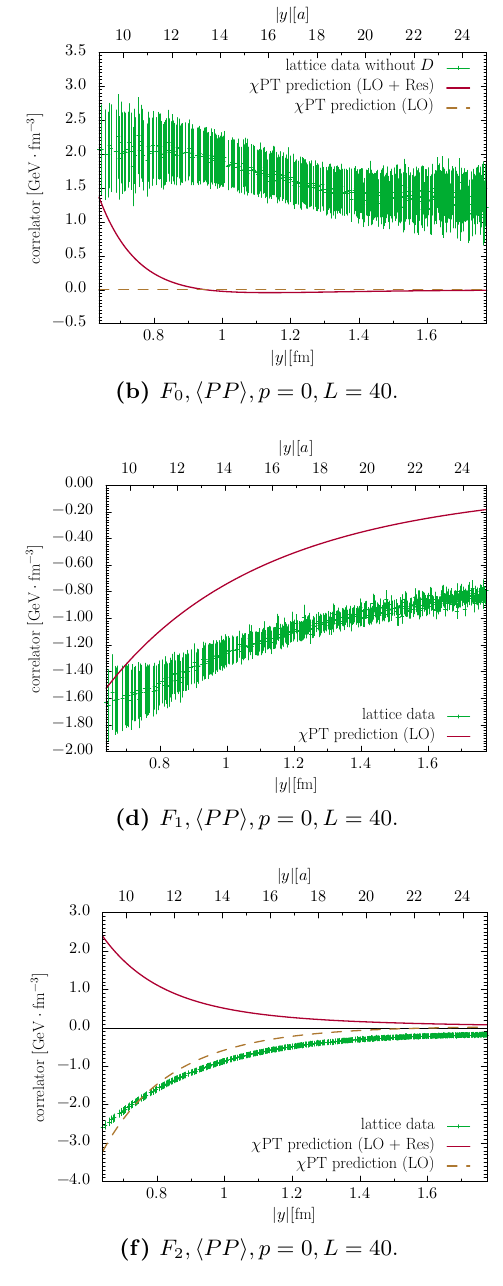
SS and PP . The resonance exchange contri- h i h i